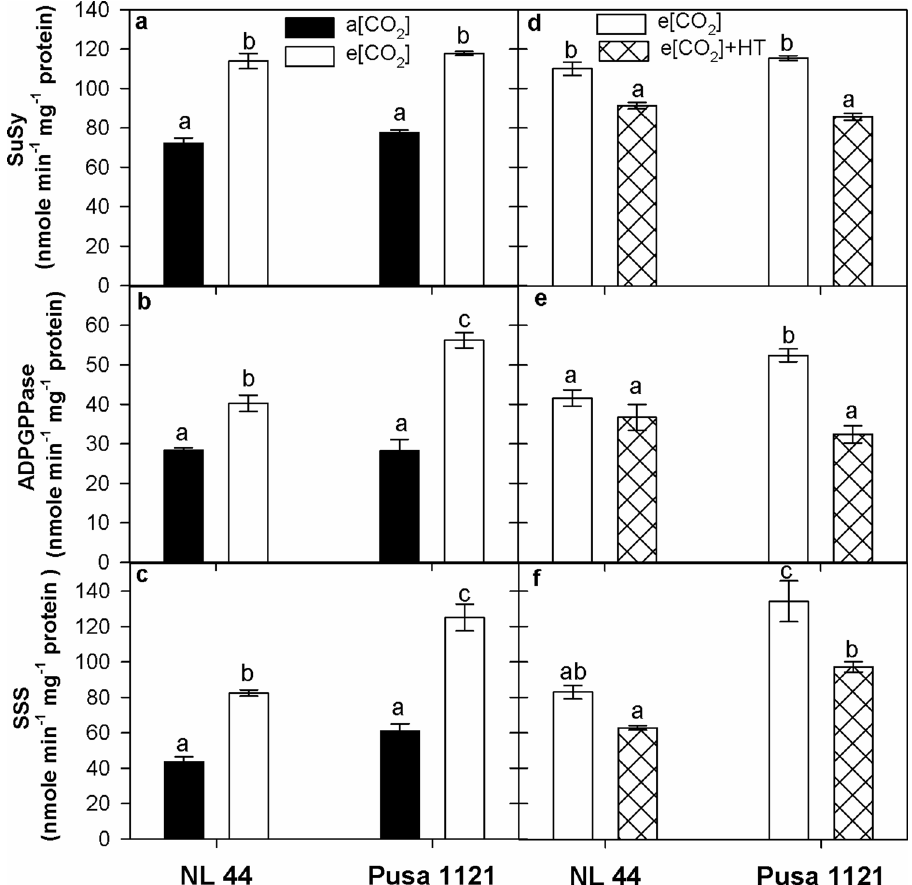
Figure 4. Sucrose synthase ( a , d ), ADP glucose pyrophosphorylase ( b , e ) and soluble starch synthase ( c , f ) activity in spikelets of rice cultivars NL-44 and Pusa 1121 at 10 days post 100% flowering (10 DPF) under ambient and elevated [CO 2 ] during 2013 ( a – c ) and elevated [CO 2 ] and elevated [CO 2 ] + HT environment during 2014 ( d – f ). Each vertical column represents mean of three replicates. Bars indicate ± SE. Comparison of means was obtained from Tukey’s honest significant difference test individually for 2013 and 2014 experiments. Means with the same letter are not significantly different at 5%. [SuSy = sucrose synthase; ADPGPPase = ADP glucose pyrophosphorylase; SSS = soluble starch